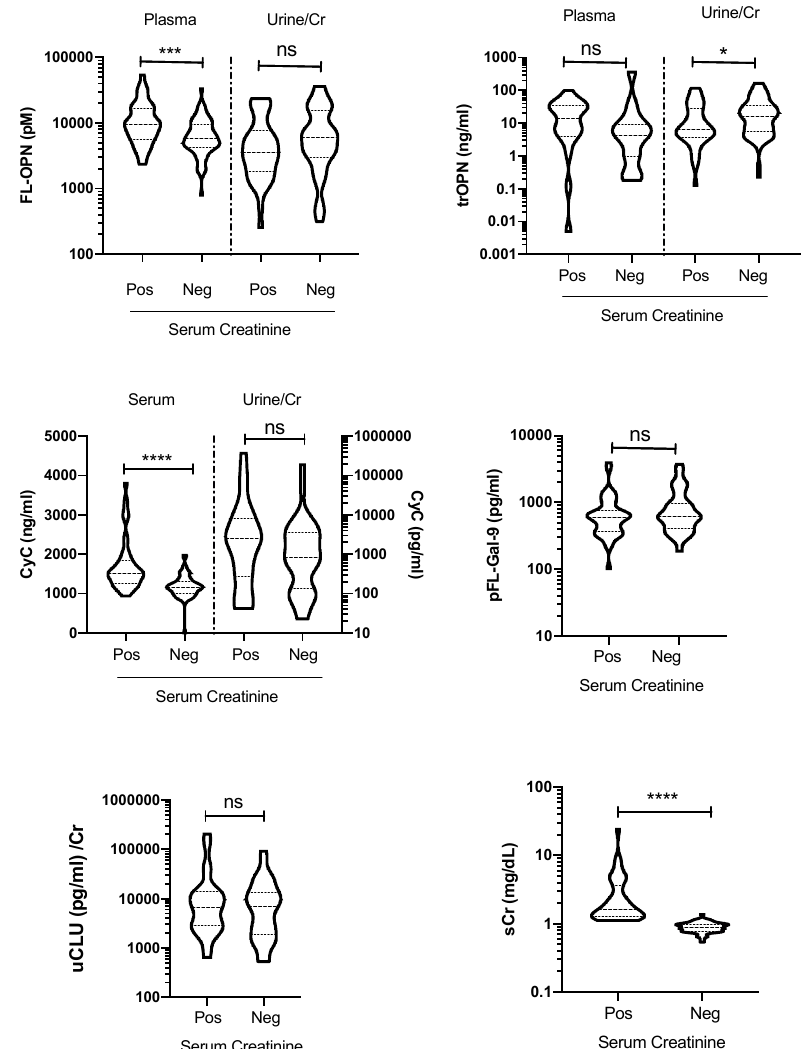
Figure 5. The levels of biomarkers in the plasma (p), serum (s), and urine (u) were assessed in the serum creatinine-positive (Pos) and -negative (Neg) groups. p value is written as: ns, no significant; * p < 0.05, *** p < 0.001, **** p < 0.0001. FL-OPN, full-length osteopontin; tr-OPN, thrombin-cleaved osteopontin; CyC, cystatin C; FL-Gal-9, full-length galectin-9; CLU, clusterin; Cr, creatinine.